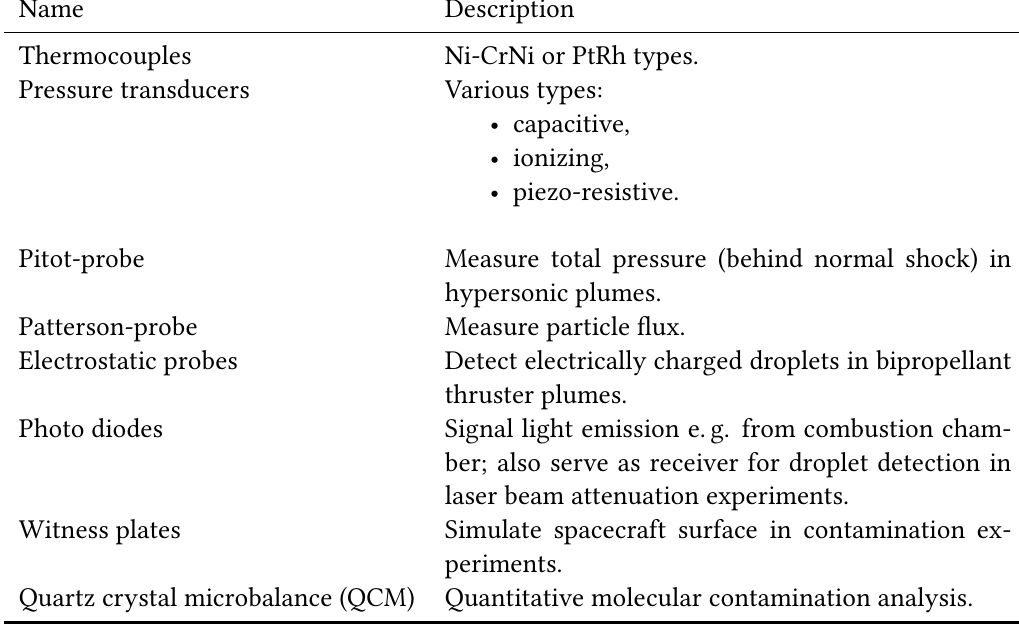
Table 3: Some measurement devices employed in plume